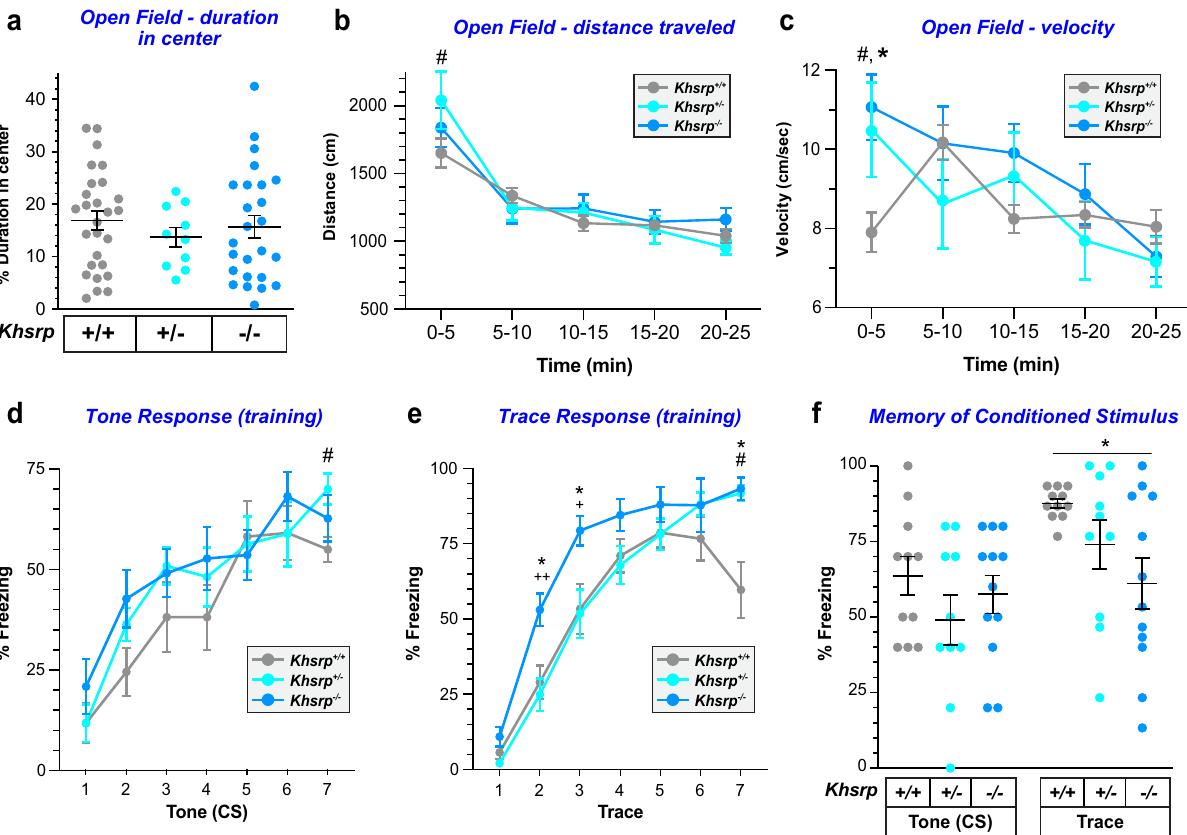
Fig. 6 KHSRP de fi cient mice show increased locomotor activity and impaired hippocampal-dependent memory consolidation. a Mice with decreased KHSRP levels display no difference in percentage of time in the center in the Open fi eld test. b , c Khsrp − / − and Khsrp + / − mice have increased locomotor activity in the fi rst 5min for day 1 as measured by distance traveled ( b ) or velocity ( c ) but decreased locomotor activity over time all values are mean±SEM ( N = 28 for Khsrp + / + and Khsrp − / − and n = 10 for Khsrp + / − ; repeated measures ANOVA show a signi fi cant time × genotype interaction p = 0.0026). Tukey post-hoc tests revealed that the fi rst bin (0 – 5min) is signi fi cantly different from all other time points for both distance traveled and velocity. This difference is driven by the Khsrp + / − mice for distance traveled (ANOVA F (2,60) = 0.2306, p = 0.0449, # p ≤ 0.05 Khsrp + / − vs. Khsrp + / + ), while for velocity Khsrp + / − and Khsrp − / − animalsarebothsigni fi cantlyelevatedcomparedto Khsrp + / + (ANOVA F (2,60) = 1.895, p = 0.0064, ## p ≤ 0.01 Khsrp + / − vs. Khsrp + / + and p = 0.0442,* p ≤ 0.05 Khsrp − / − vs. Khsrp + / + ). d , e Allmicedemonstrateincreasedfreezingduringtrainingwithincreasingpresentationsoftheconditionedstimulus(CS;tone, d )andthe trace interval following CS ( e ). Notably, Khsrp + / − mice show increased freezing vs. Khsrp + / + mice at the last tone and trace interval presentation. Khsrp − / − mice also show increased freezing during the trace period during training vs. Khsrp + / + and Khsrp + / − . Data are shown as mean±SEM, n = 11 (6 male and 5 females/ genotype; + p ≤ 0.05 and ++ p ≤ 0.01 for Khsrp + / − vs. Khsrp − / − mice, and * p ≤ 0.05 Khsrp − / − vs. Khsrp + / + and # p ≤ 0.05 Khsrp + / − vs. Khsrp + / + by repeated measures ANOVA followed by one-way ANOVA for each time point). f All mice freeze equally during CS presentation approximately 24h after training, but Khsrp − / − mice display decreased freezing during the trace interval compared to Khsrp + / + . Data are shown as mean±SEM, n = 11 (6 male and 5 females/ genotype; one-way-ANOVA ( F (2,27) = 3.948, p = 0.0149, * p ≤ 0.05). See Supplementary Fig. 6 for sex-speci fi c responses of each